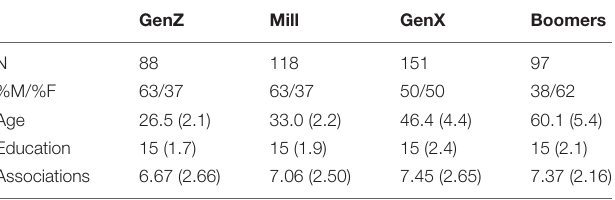
TABLE 1 | Demographic information on the three